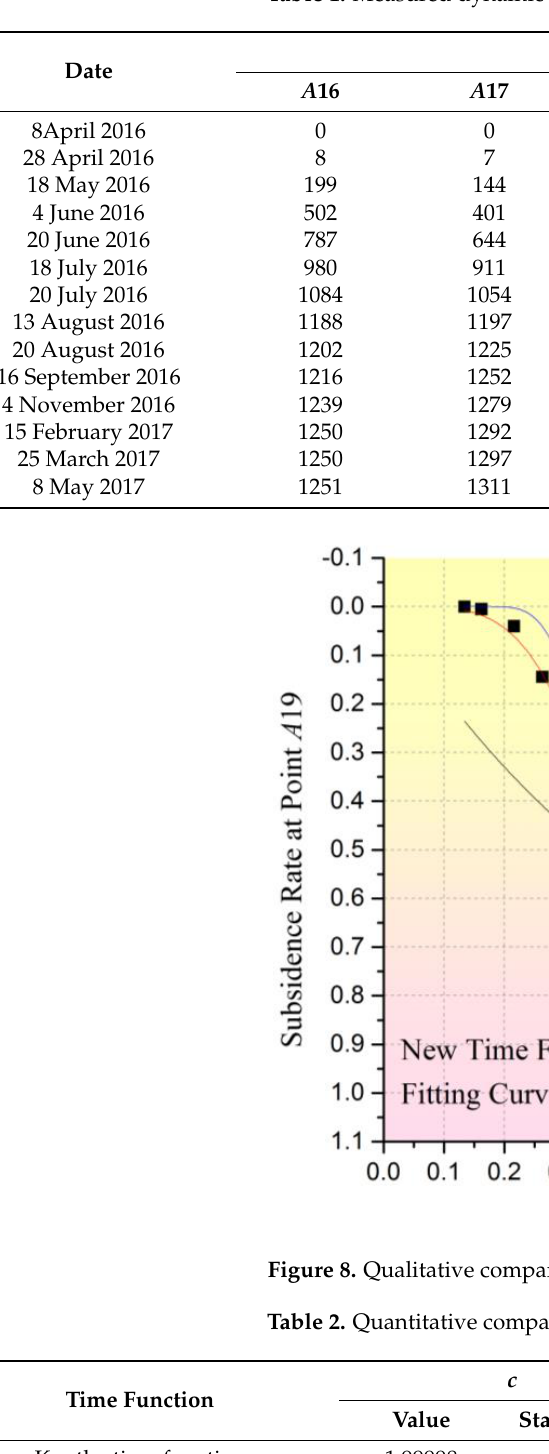
Table 1. Measured dynamic subsidence data at point A 16– A 21.